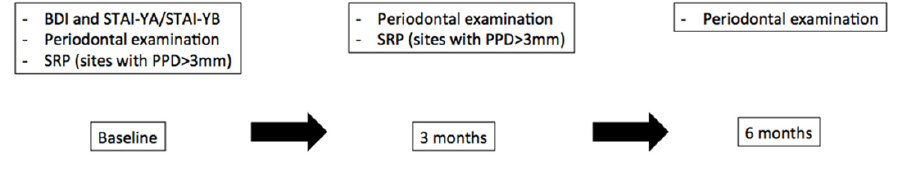
Figure 1. Flow chart of the study.